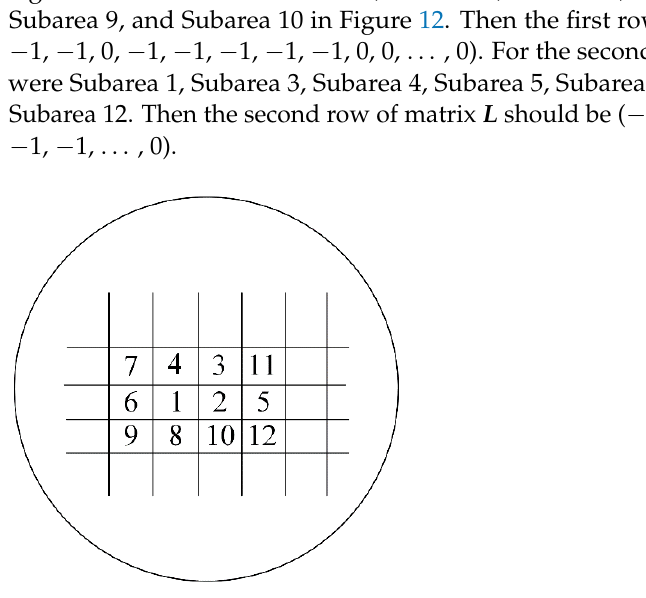
Figure 12. Relative positions between different subareas.